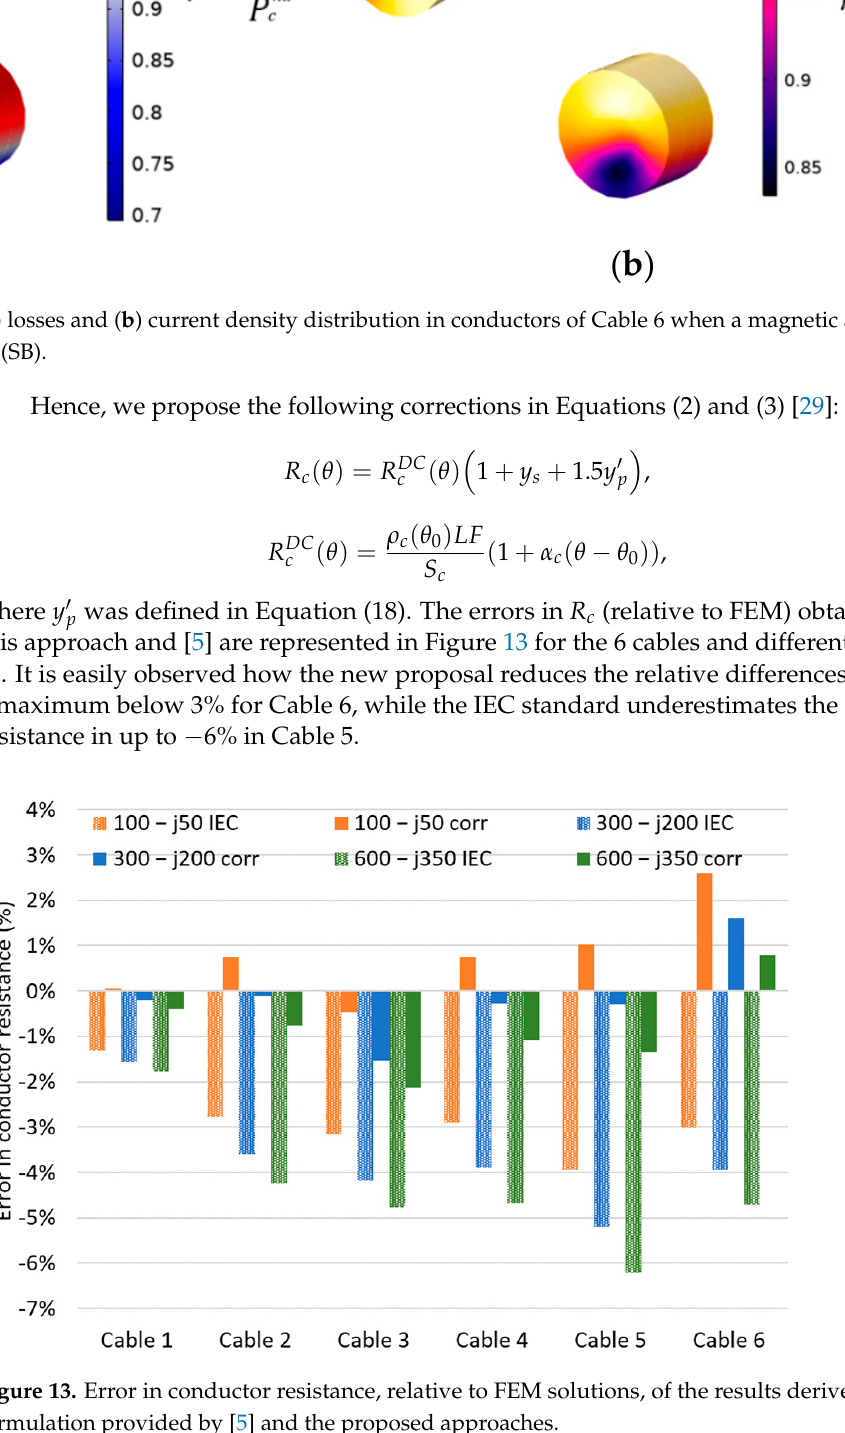
( b ) Figure 14. Evolution of ( a ) the total sheath losses and ( b ) the sheath loss factors with CP and the armor permeability in Cable 6 (SB).